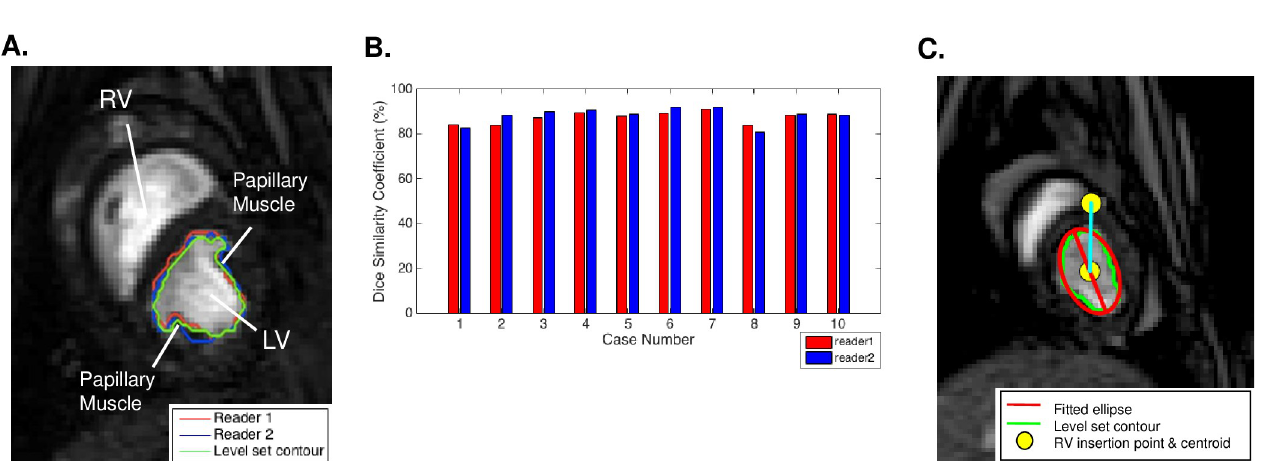
Fig 3. (A) Representative midventricular short-axis image of the LV showing level set and manual contours. Green = automatic contouring, Red = manual contour reader 1, Blue = manual contour reader 2. (B) Dice similarity coefficient for all 10 cases. ( C ) Representative midventricular short-axis image of the LV overlaid with automatic contours and fitted ellipse for quantifying major/minor axis length and major axis orientation angle as surrogate measurement of LV shape change. Red = fitted ellipse. Green = automatic contouring. Yellow circle = RV insertion point and centroid of ellipse.